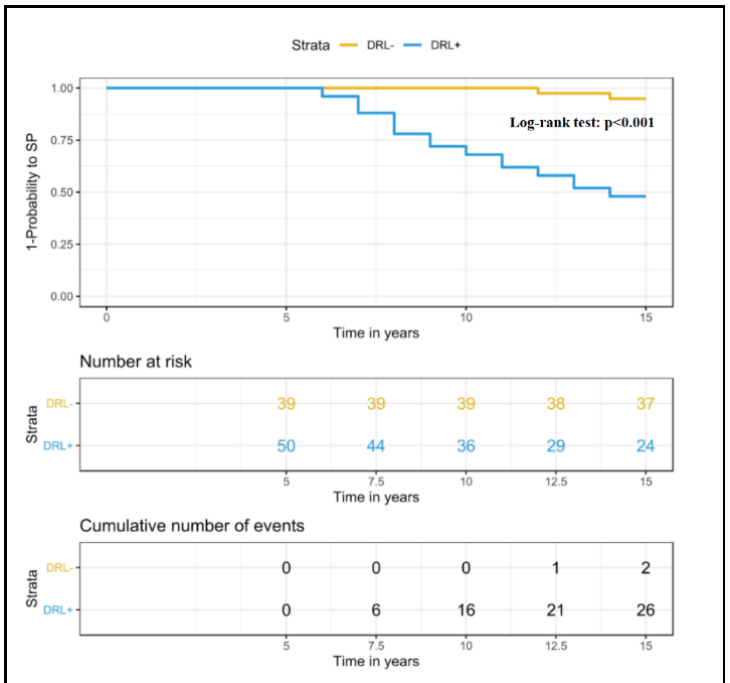
Figure 4. Survival curves plotted using the Kaplan–Meier method show the time from assignment to GroupDRL+ at T0 to the onset of SPMS, over a 15-year follow-up. DRL = dark rim lesions; SP = secondary progressive MS.